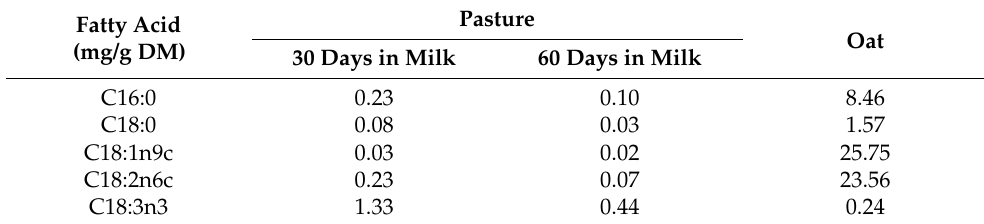
Table 1. Fatty acid composition of pasture and